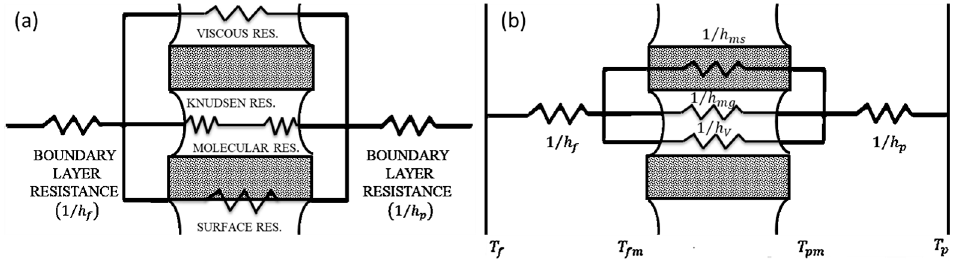
Figure 3. ( a ) Mass transfer and ( b ) heat transfer in membrane distillation. The mass balance across the feed side boundary layer yields the relationship between